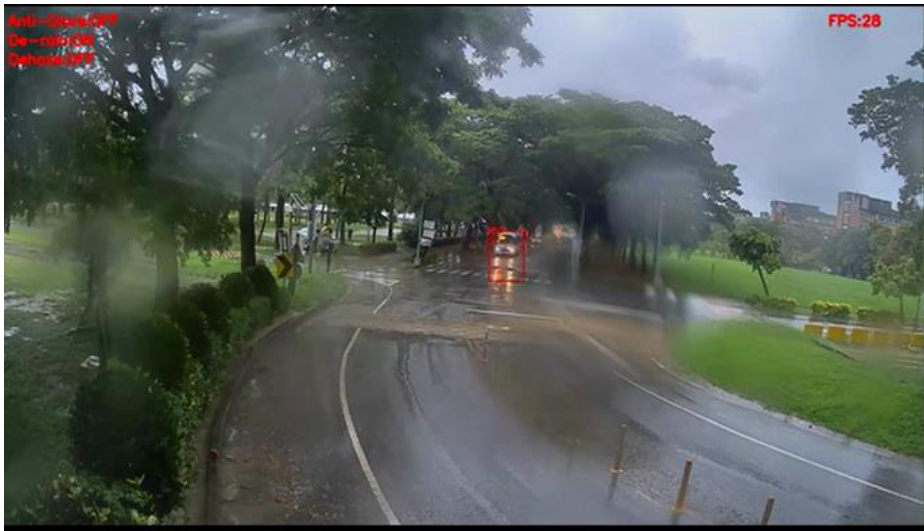
Figure 32. Rainy scene image frame detected by our proposed system.